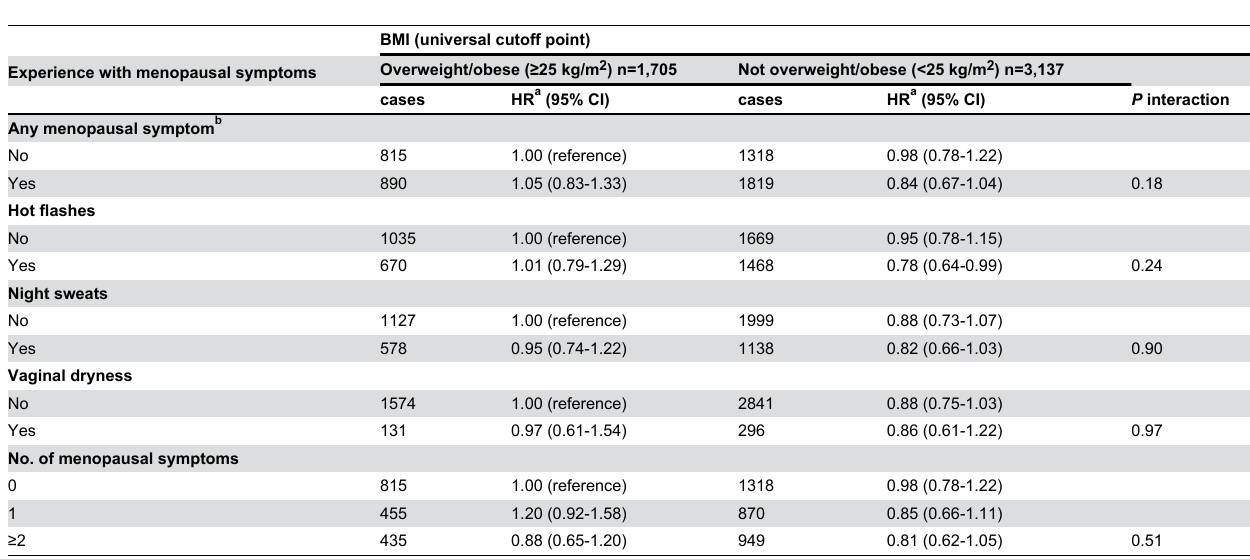
Table 3. Postdiagnosis menopausal symptoms in association with breast cancer recurrence by body-mass-index (BMI), SBCSS